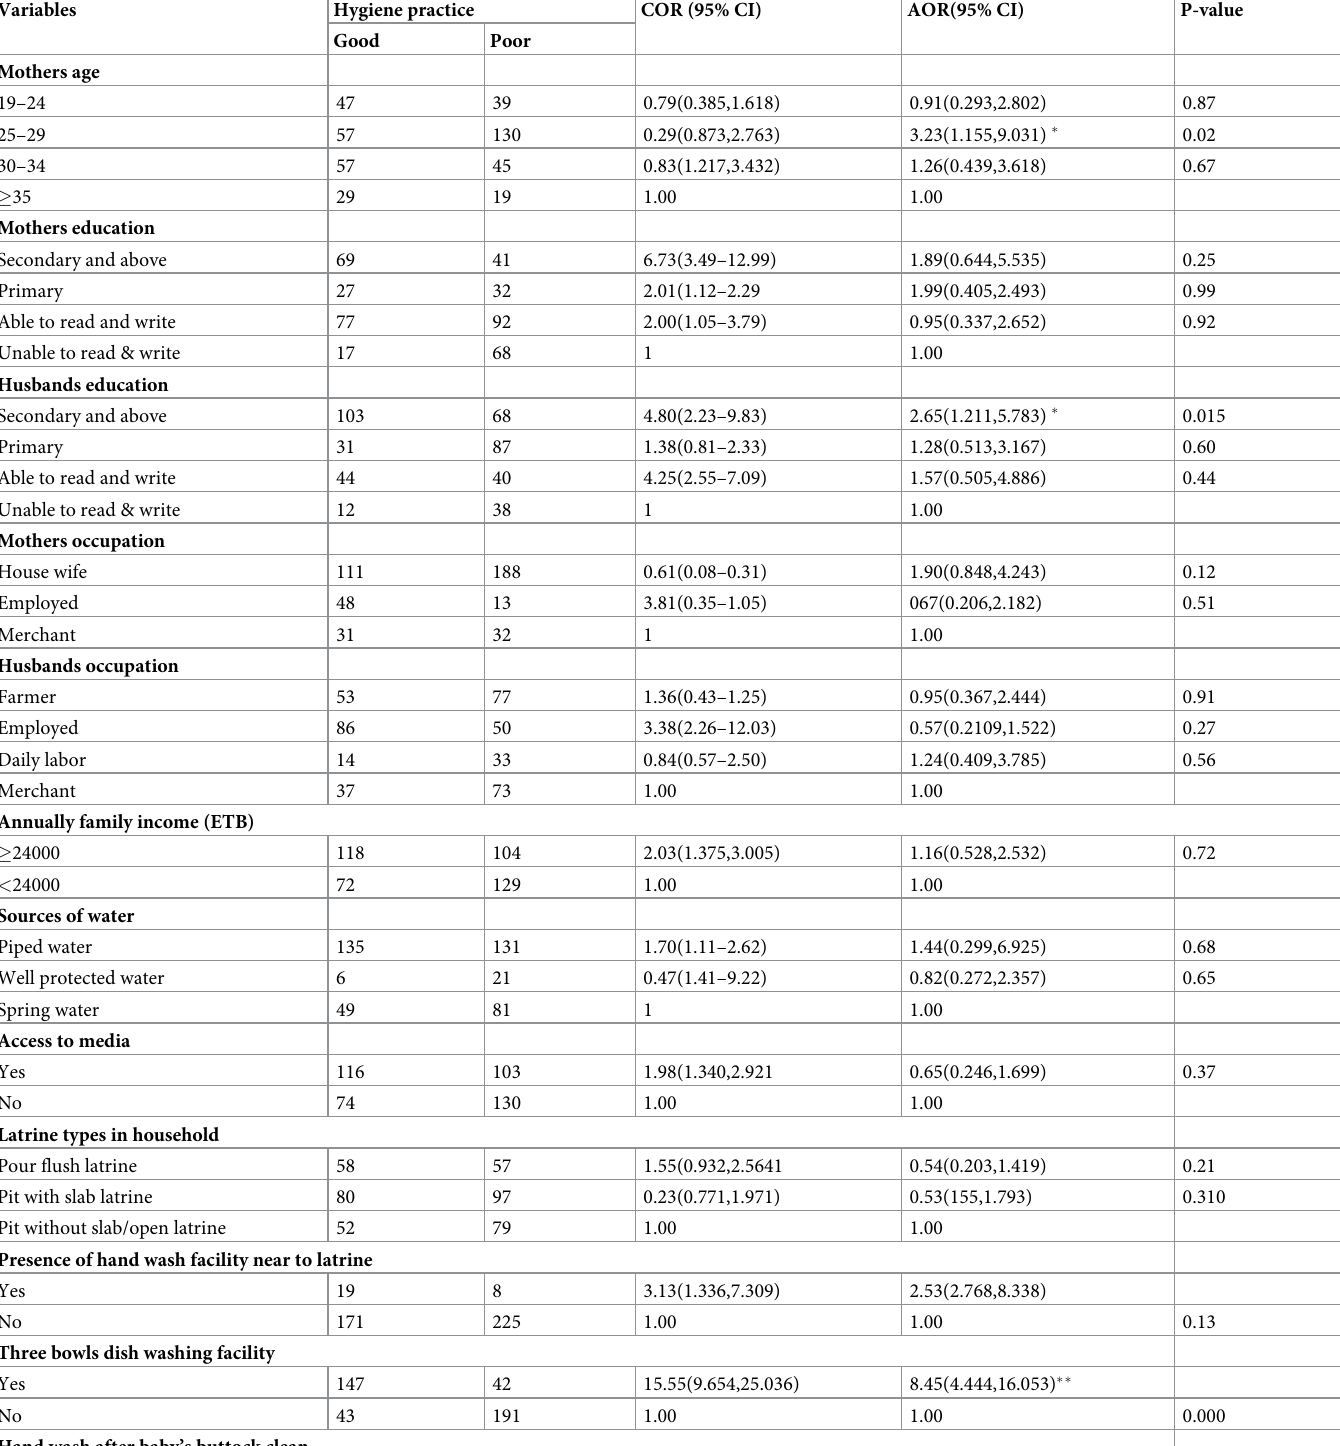
Table 6. Bivariate and multivariable logistic regression analysis of factors associated with hygiene practice during complementary food preparation among mothers with 6–24 months aged of children in Debark town, Ethiopia, 2021.